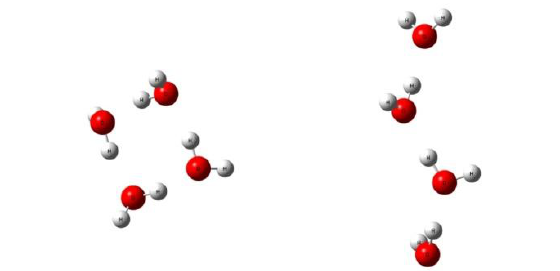
Figure 7. Left: Cluster of 4 water molecules in the absence of an electric field. Right: linear water whisker in a field F = 0.5